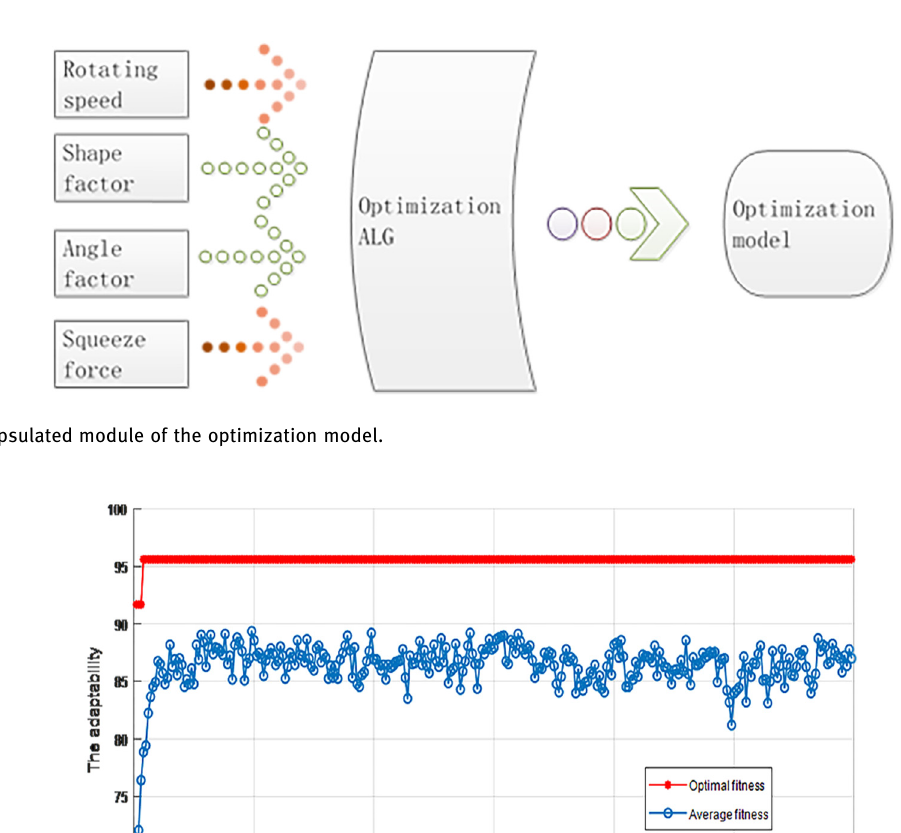
Figure 7: Line charts of the maximum value of maximum crushing force.